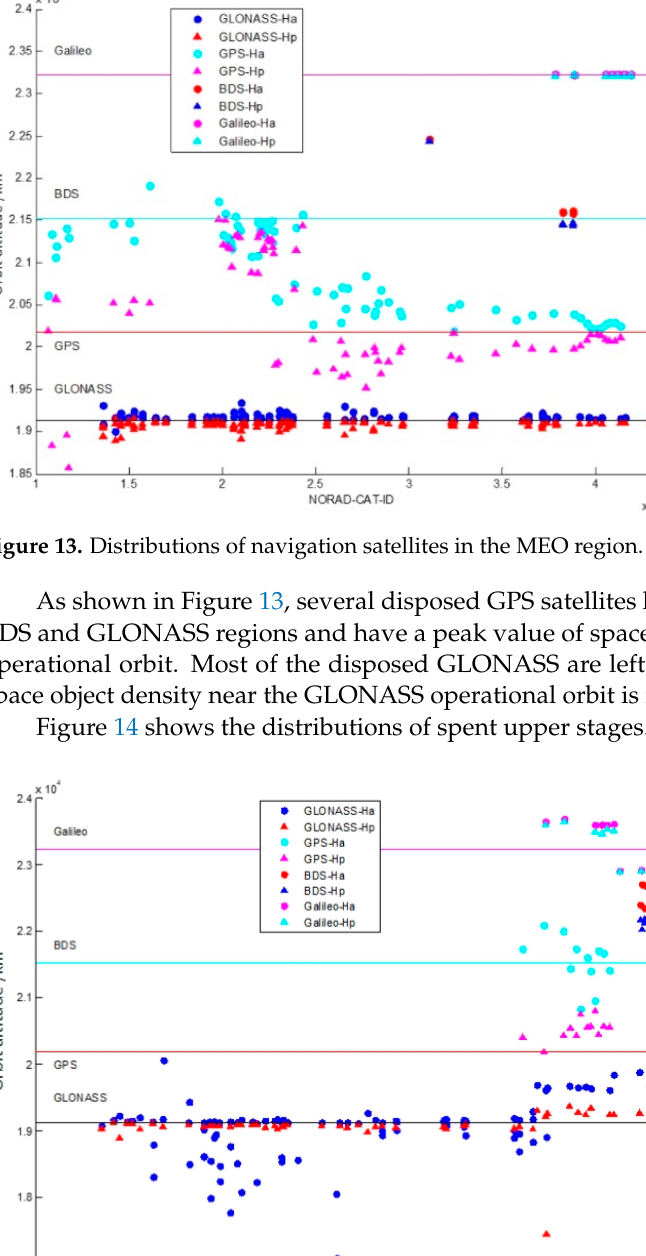
Figure 14. Distributions of spent upper stages in the MEO region.